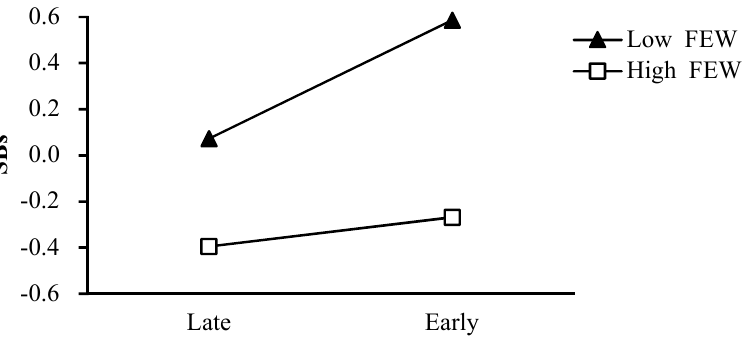
Figure 3. The two − way interaction between PT and FEW in predicting girls’ SBs. Note: PT pubertal timing, FEW father emotional warmth, SBs smoking behaviors.